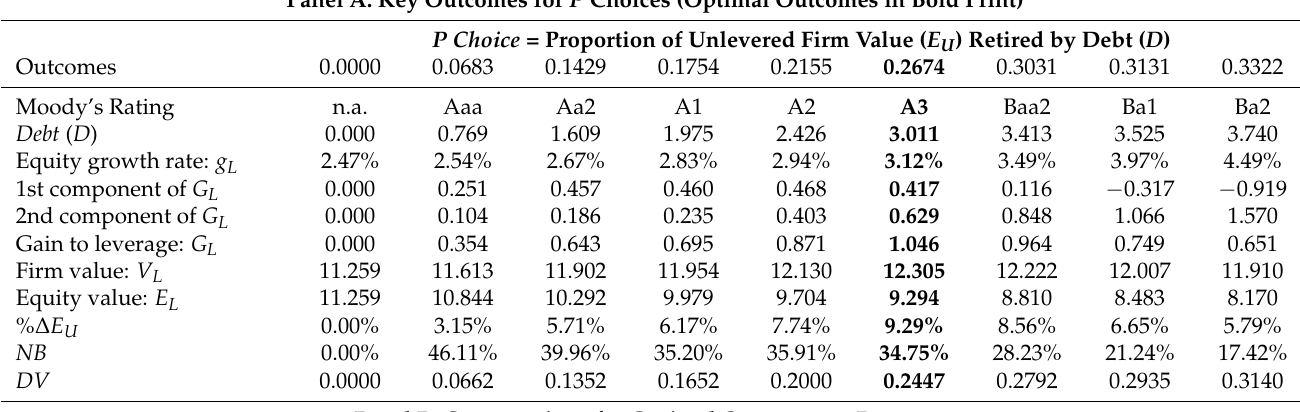
Panel B. Computations for Optimal Outcomes at P =